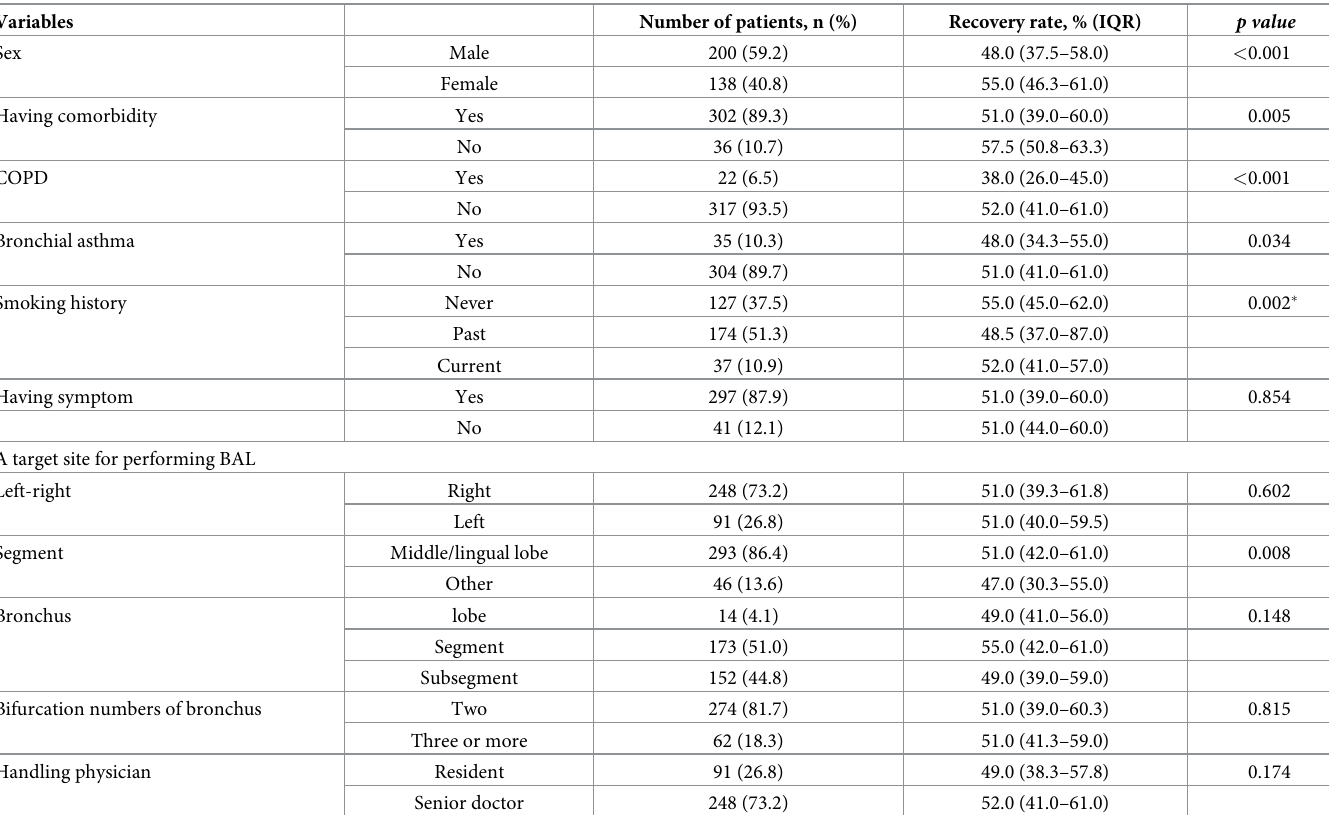
Table 2. Factors affecting the recovery rate of BAL.